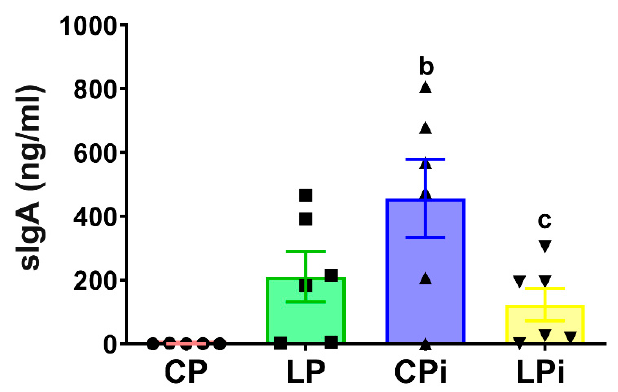
Figure 9. Levels of secreted IgA in duodenum of malnourished BALB/c mice infected with L. infantum . The levels of secreted IgA measured by ELISA according to the protocol described in materials and methods. Significant differences due to infection (b), p < 0.05; significant differences due to interaction between diet and infection (c), p < 0.01. CP: animals fed 14% protein diet; LP: animals fed 4% protein diet, CPi: animals fed 14% protein diet and infected; LPi: animals fed 4% protein diet and infected.